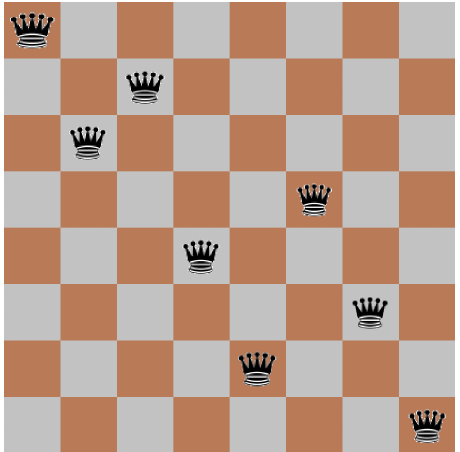
Figure 1. Potential chromosome for 8-Queens Problem where queen 1 is hitting queen 8, and two queens (2, 3) are hitting each other and also hitting two other queens (4, 7) yielding a loss of 4 where the four hitting pairs are ([1, 8], [2, 3], [2, 4], [3,